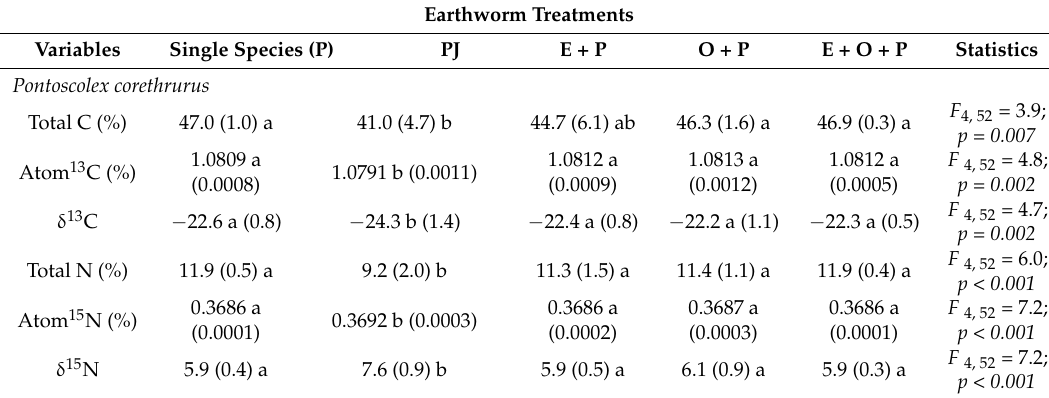
Table 4. Earthworm tissue total carbon (C) and nitrogen (N) percentages (%), atom percentages of 13 C and 15 N (%) and delta 13 C ( δ 13 C; ‰) and delta 15 N ( δ 15 N; ‰) in native earthworms Estherella spp. (E) and Onychochaeta borincana (O) at each earthworm mesocosm from different earthworm treatments at the end of the 22-day experiment with Puerto Rican